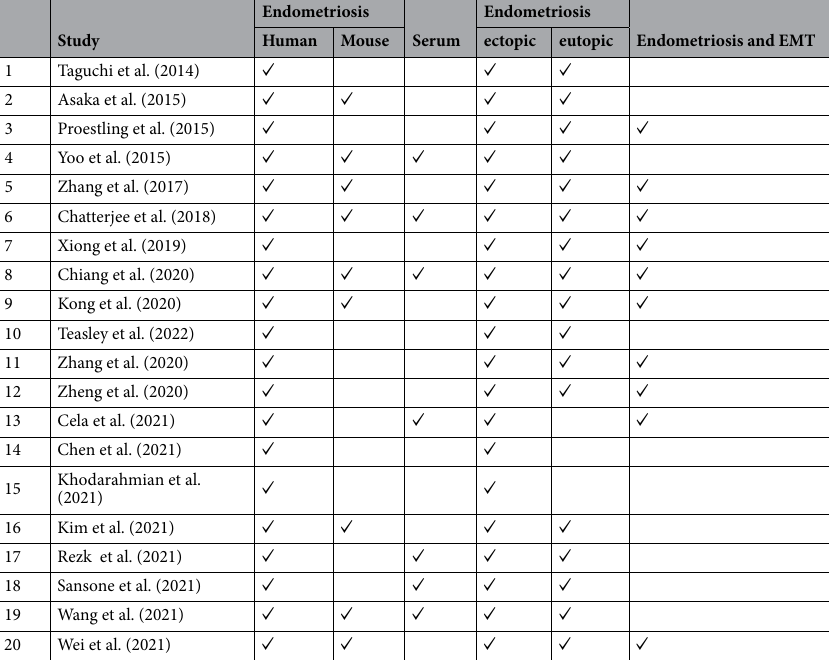
Table 1. The literature has demonstrated that EMT and endometriosis are closely associated with SIRT1